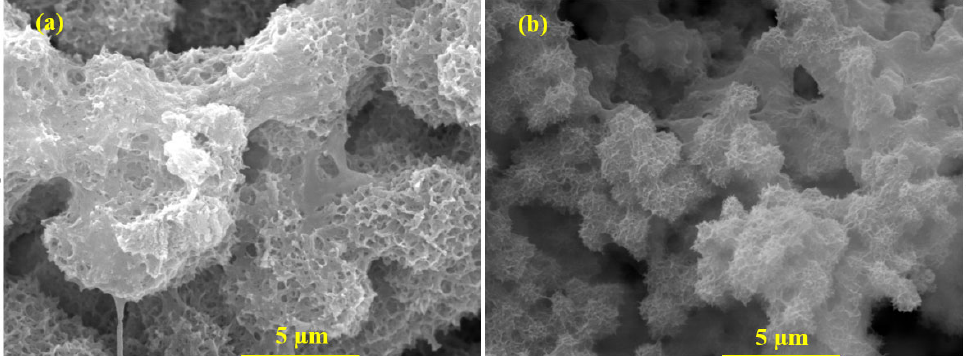
Figure 12. SEM of corrosion products formed on ( a ) Al and ( b ) Al-5 Mg coatings after 41 d of im- mersion in 3.5 wt.% NaCl solution. Table 4. EDS analysis of the corrosion